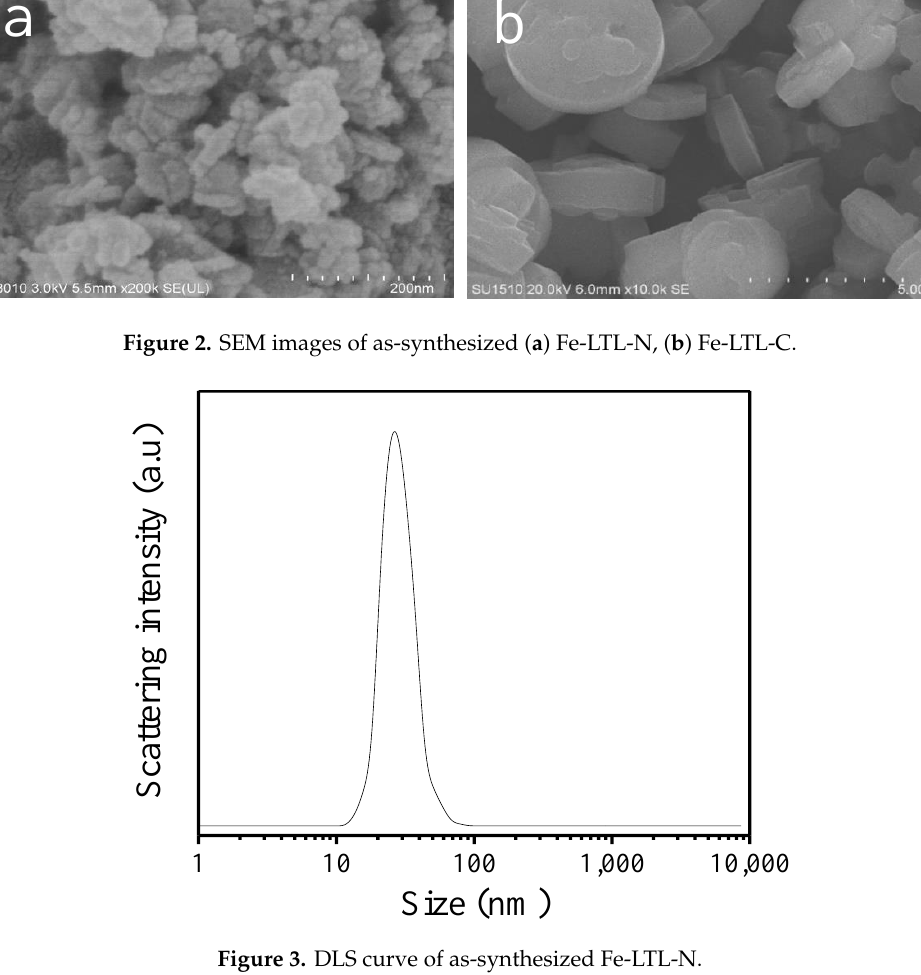
Figure 1. XRD patterns of ( a ) as-synthesized Fe-LTL-N, ( b ) calcined Fe-LTL-N, ( c ) as-synthesized Fe-LTL-C, ( d ) calcined Fe-LTL-C, respectively.